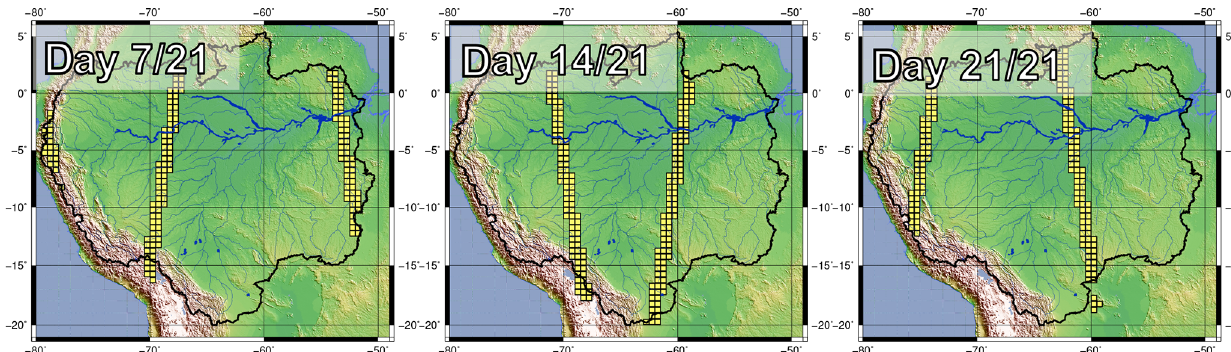
Figure 2. SWOT swaths at ISBA-CTRIP resolution over the Amazon